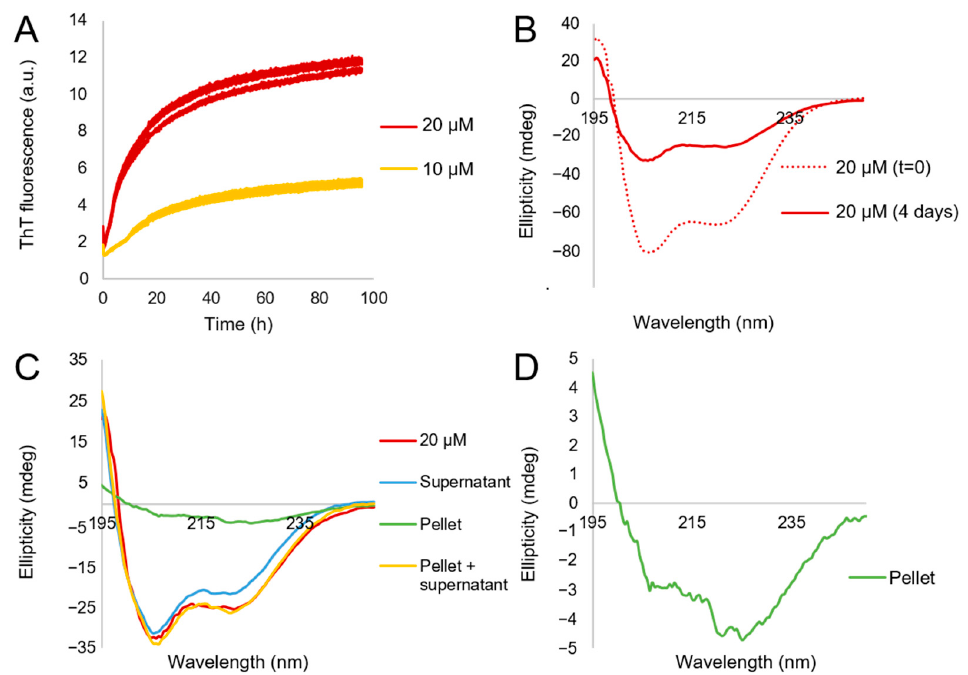
Figure 3. Time evolution of ThT fluorescence and CD spectra of the ApoA-I mutant K107 ∆ in phosphate buffer at pH 6.0. ( A ) The ThT fluorescence intensity over time for 10 and 20 µ M protein in triplicates. The initial decrease in ThT fluorescence signal is due to temperature stabilization. ( B ) The observed CD spectrum for the initial state (t = 0, dotted line) and at a later stage (4 days, red line). ( C ) The observed CD spectra after separation of the soluble (blue) and insoluble fractions (green). The 4 days sample from panel ( B ) (red) is included for comparison. The two spectra of the supernatant and the pellet were summed (yellow), to compare their superposition to the spectrum of the non-separated sample. ( D ) Zoom-in on the pellet sample spectrum in ( C ), to observe this weak spectrum more easily.